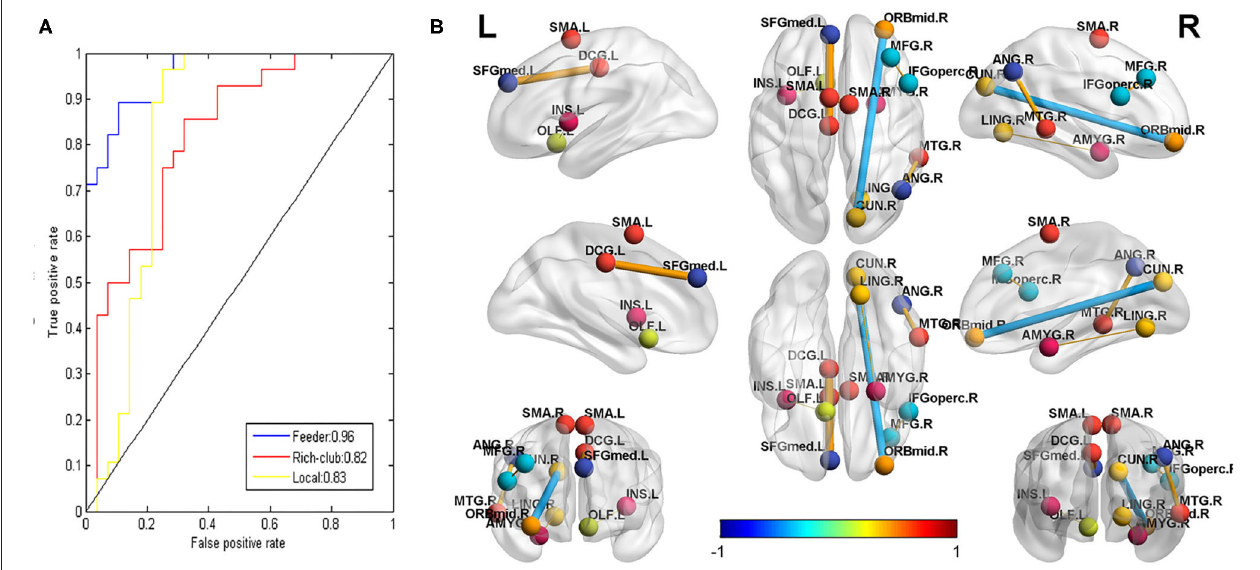
FIGURE 5 | (A) : The receiver operating characteristic (ROC) curve of the classifier for rich-club (red, AUC = 0.82), feeder (blue, AUC = 0.96), and local (yellow, AUC = 0.83) connections. AUC: the area under the ROC curve. (B) : the connections that were significantly correlated with the CLCDS scores. The balls represent brain areas, and the colors of the balls indicate the intrinsic connectivity networks. The size and color of the lines (connections) represent the r -value and correspond to the color bar.